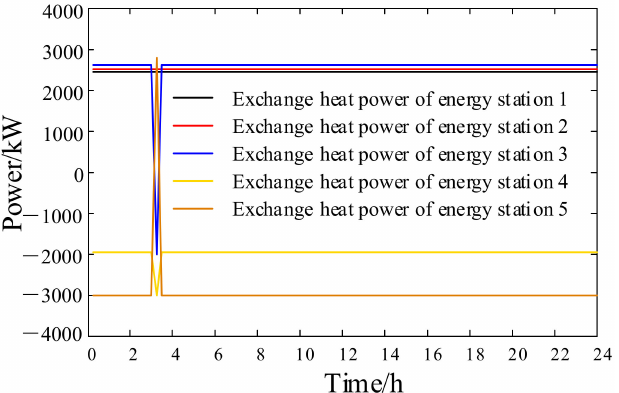
Figure 12. Transfer power of hot-water pipelines between multi-energy stations in the